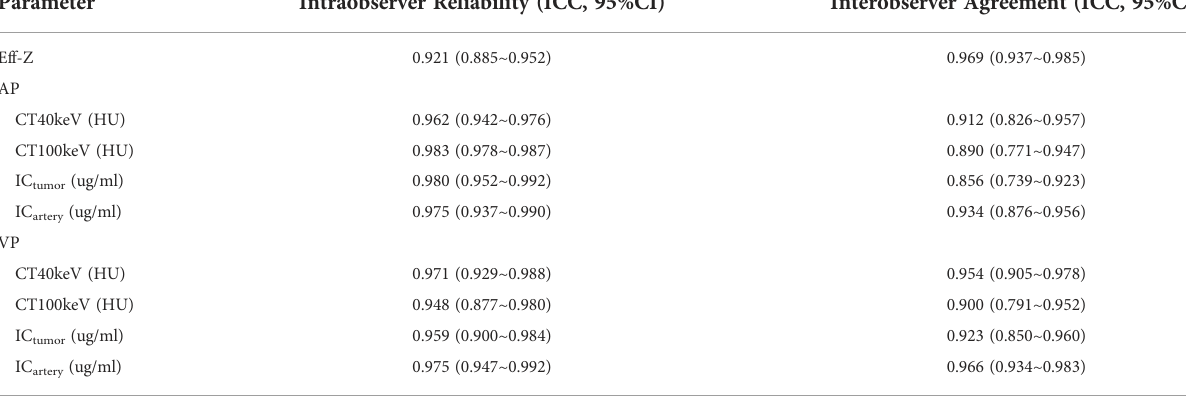
TABLE 2 Intraobserver reliabilty and interobserver agreement of DLCT parameter measurement.